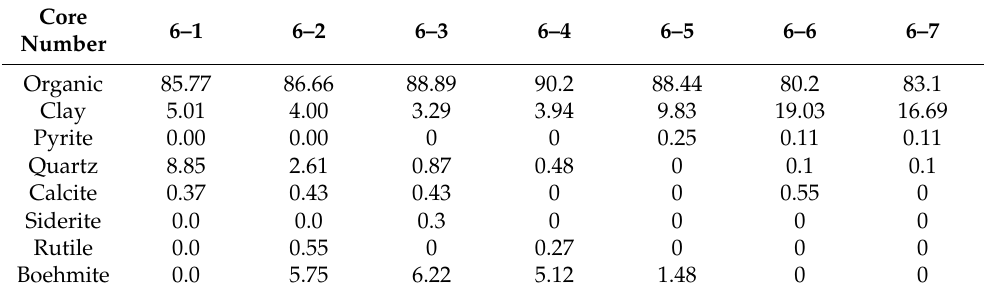
Table 4. Volume contents of all cores sampled from No. 6 coal in the Heidaigou mine.